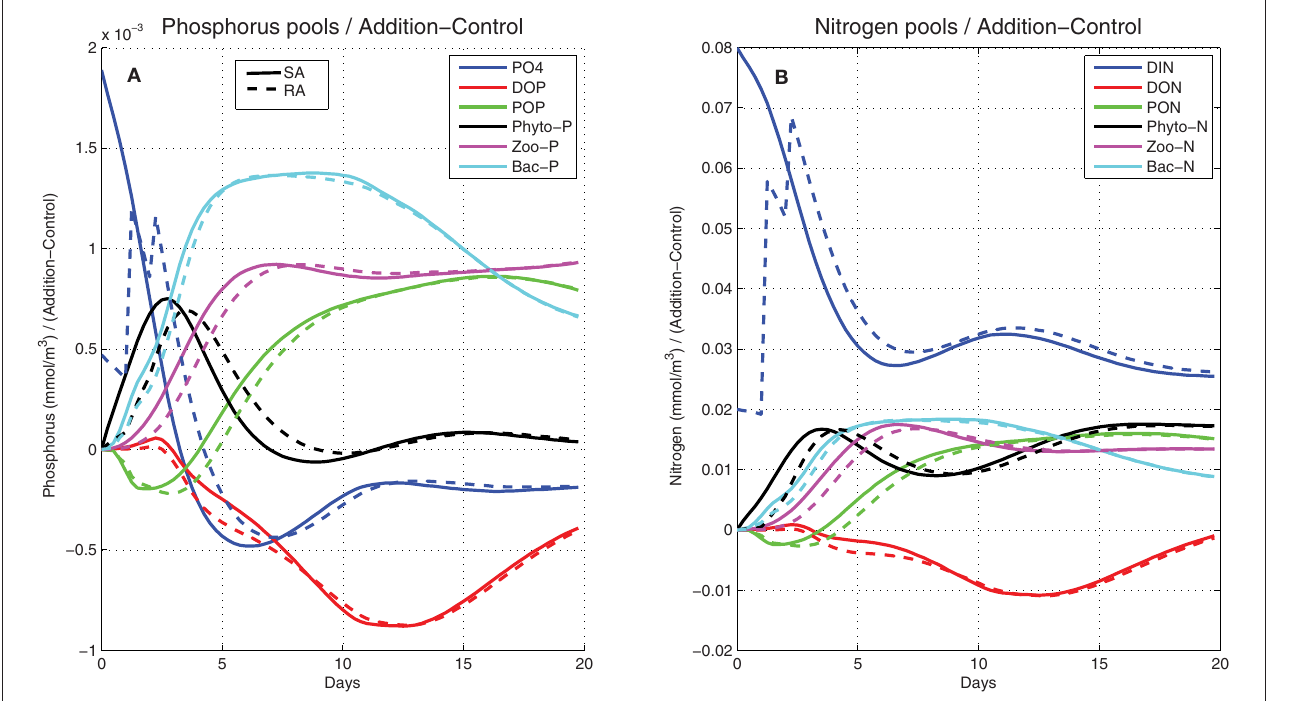
FIGURE 7 | Simulated difference between the addition (SA, continuous line; RA dashed line) and control treatments in (A) phosphorus and (B) nitrogen pools (mmol/m 3 ) in the form of dissolved inorganic (blue line), dissolved organic (red line), particulate organic (green line), phytoplankton (black line), zooplankton (magenta line), and bacteria (cyan